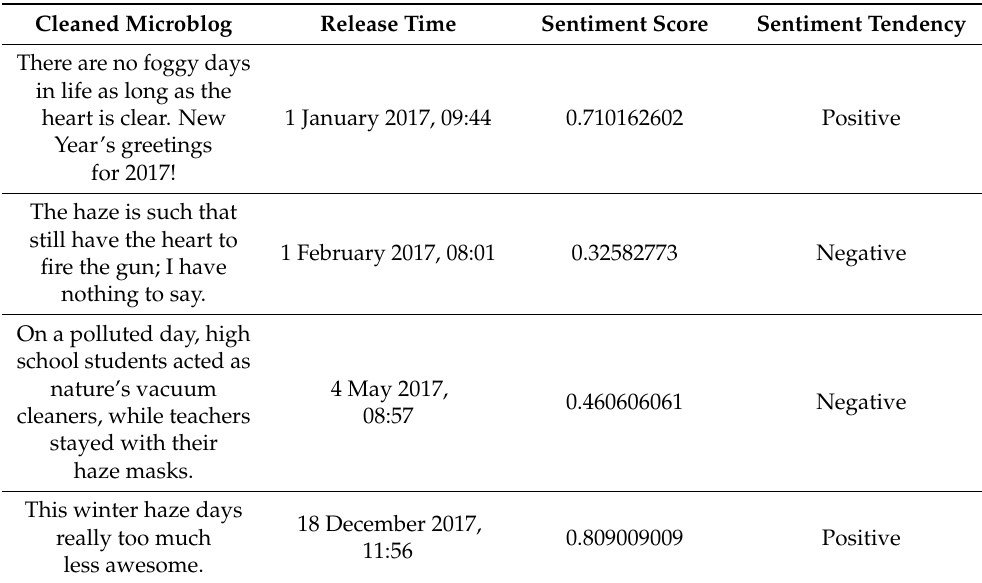
Table 4. Example of calculation result of emotion value of microblog